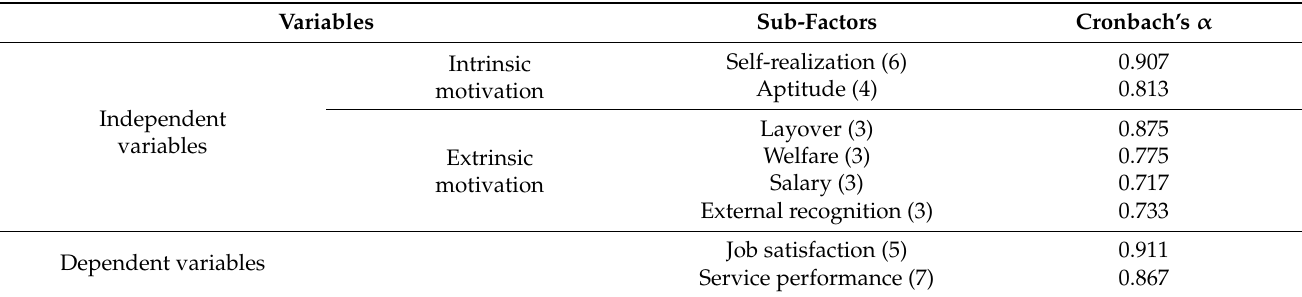
Table 2. Results of reliability